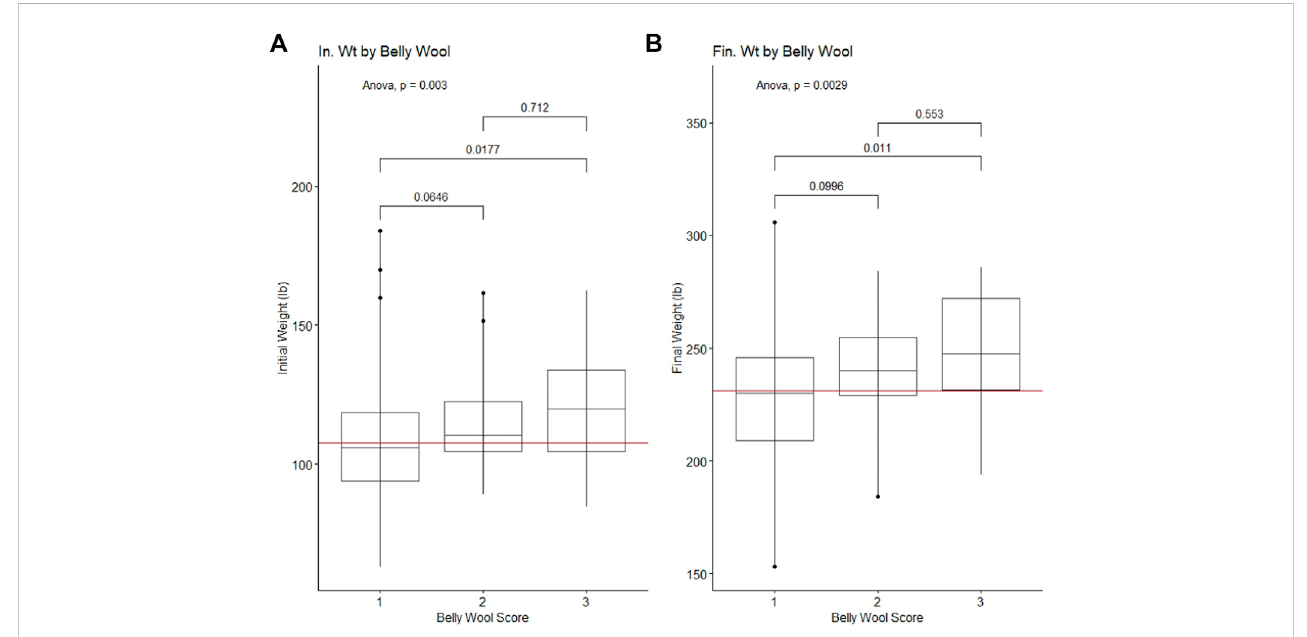
FIGURE 1 Signi fi cant ANOVA results and post-hocTukey HSD p -values for productiontraits tested against belly wool categories. (A) Initial on-test weight, (B) Final test weight. Horizontal red lines indicate the trait